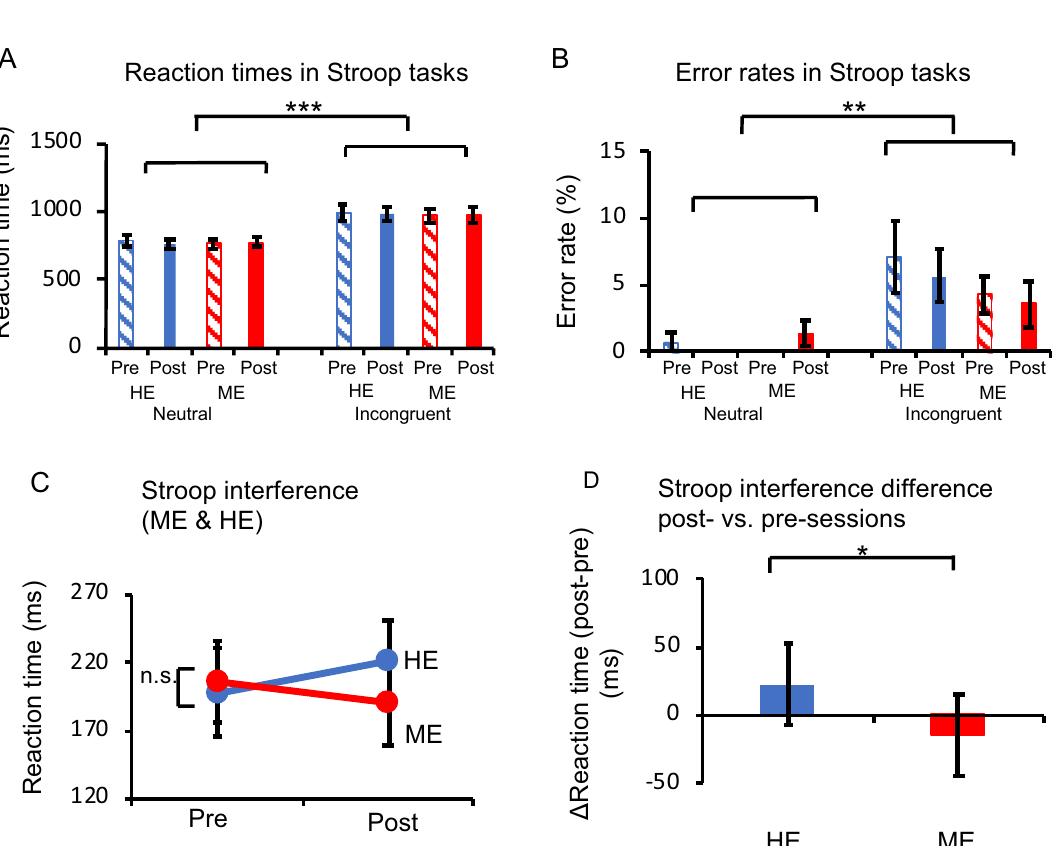
Figure 2. ( A ) Comparison of the reaction time (RT) between the incongruent and neutral conditions. The incongruent condition exhibits a significantly slower RT than the neutral condition (*** P < 0.001). ( B ) Comparison of the error rate between the incongruent and neutral conditions. Significant Stroop interference effects are observed (** P < 0.005). ( C ) The mean difference of the RT in incongruent and neutral trials indicates Stroop interference for each condition. ( D ) Stroop interference (RT) differences between post- and pre-sessions for each condition. Stroop interference differences are significantly more positive in the hypoxic exercise (HE) condition than in the milder hypoxic exercise (ME) condition (* P < 0.05). Error bars indicate the standard